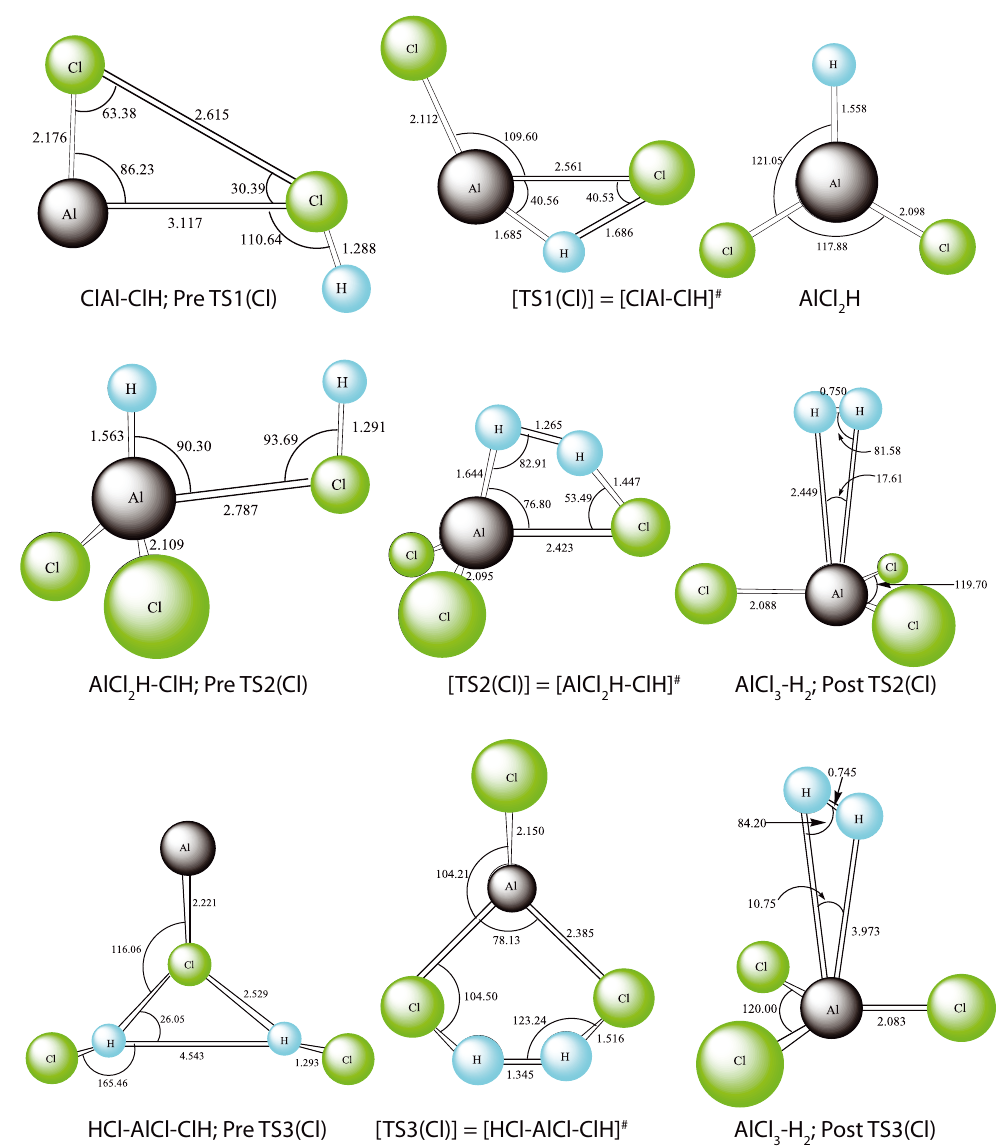
Figure 2. Optimized geometries for X = Cl. All species are C